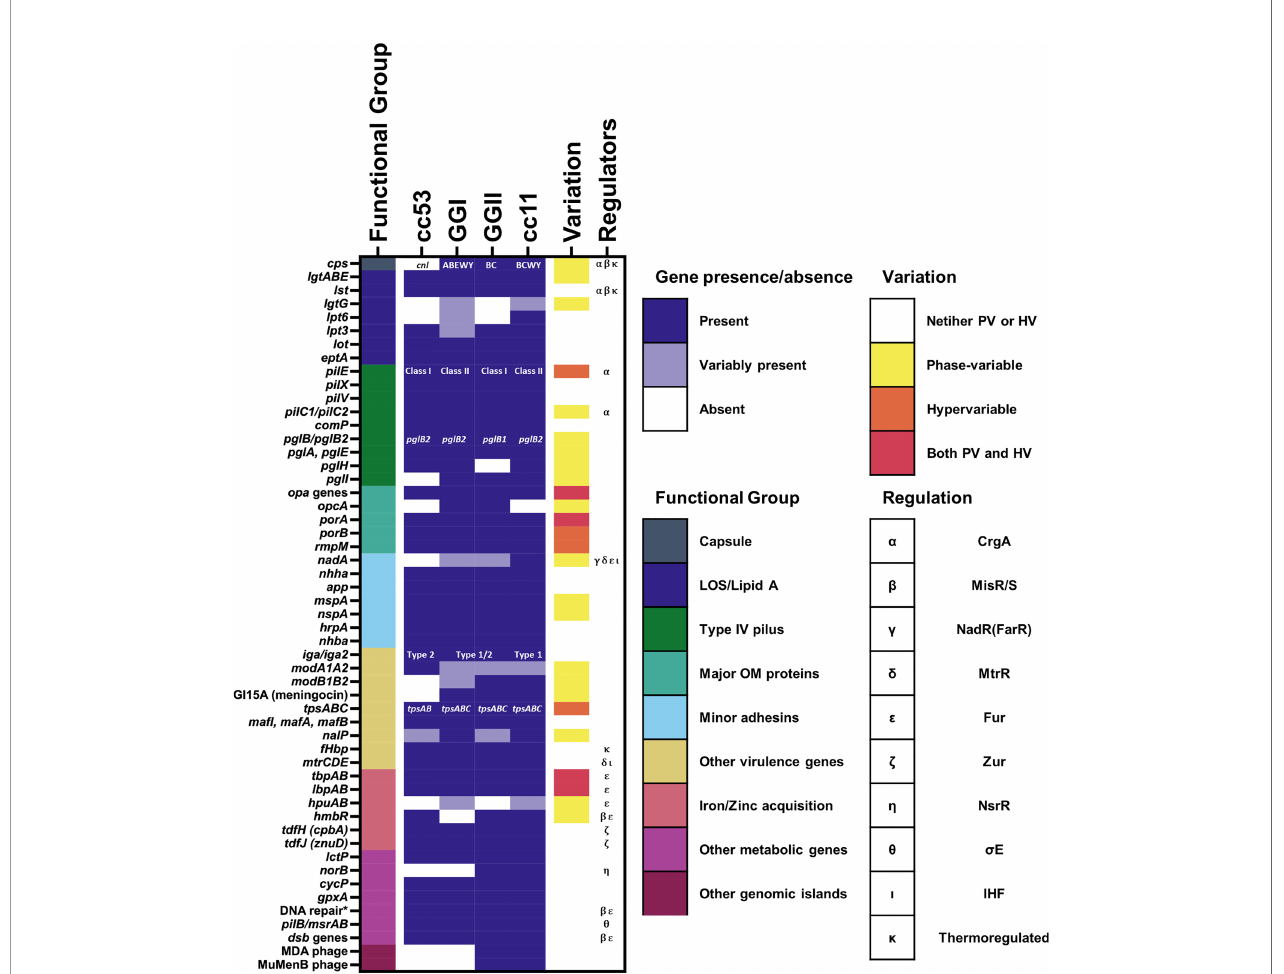
FIGURE 1 | Presence of known genes associated with pathogenesis among meningococcal lineages. The presence of genes associated with pathogenesis mentioned in this review are marked as either present (gene is present in >80% of isolates from the lineage), variably present (gene is present in 20-80% of the isolates from the lineage), or absent (gene is present in <20% of isolates from the lineage). For references see text. Lineages here are de fi ned according to the framework of Mullally et al., 2021. Where speci fi c variants of a virulence gene/island are known, i.e. for capsular serogroup, class of pilE , pglB allele, and IgA protease cleavage type, the variant predominantly associated with each lineage is indicated. The phase-variation status and known regulators of each gene are also indicated. The known regulators of each gene and the presence of phase-variation and hypervariability are also indicated. * = genes encoding DNA repair enzymes with a known role in resistance to oxidative and nitrostative stress including: nexo , nape , nth , mutM , and dinG